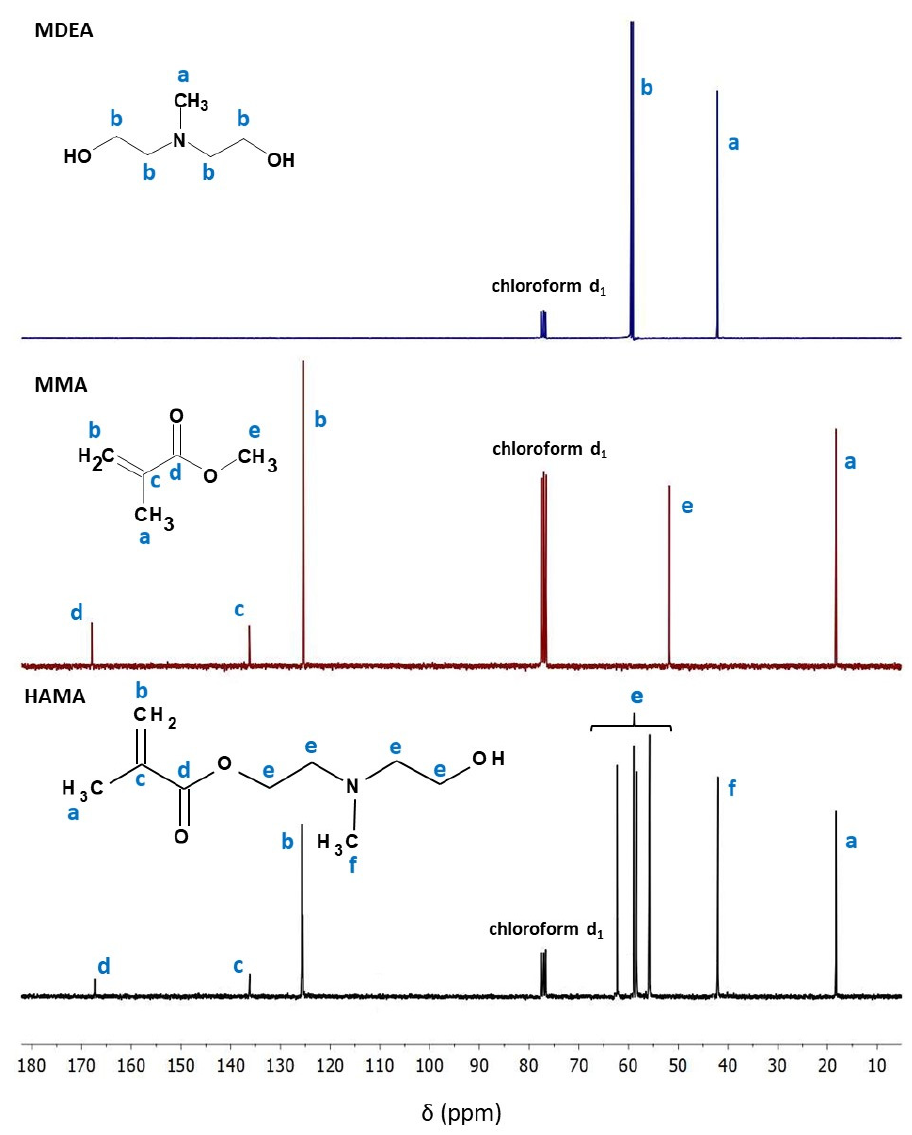
Figure 2. 13 C NMR spectra of MDEA, MMA, and HAMA.